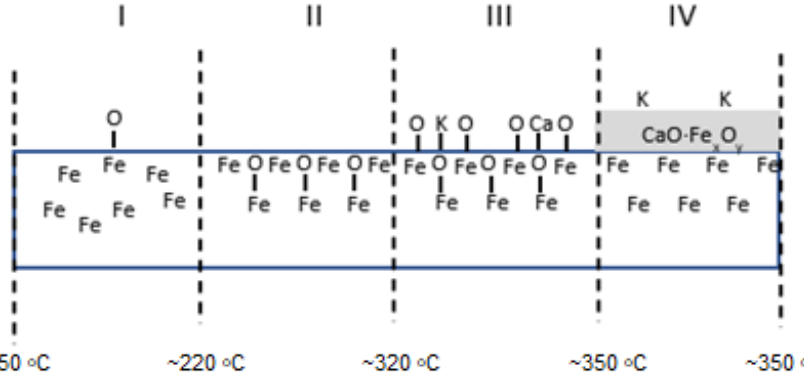
Figure 7. Schematic picture of surface structure of the Fe-Ca sample.